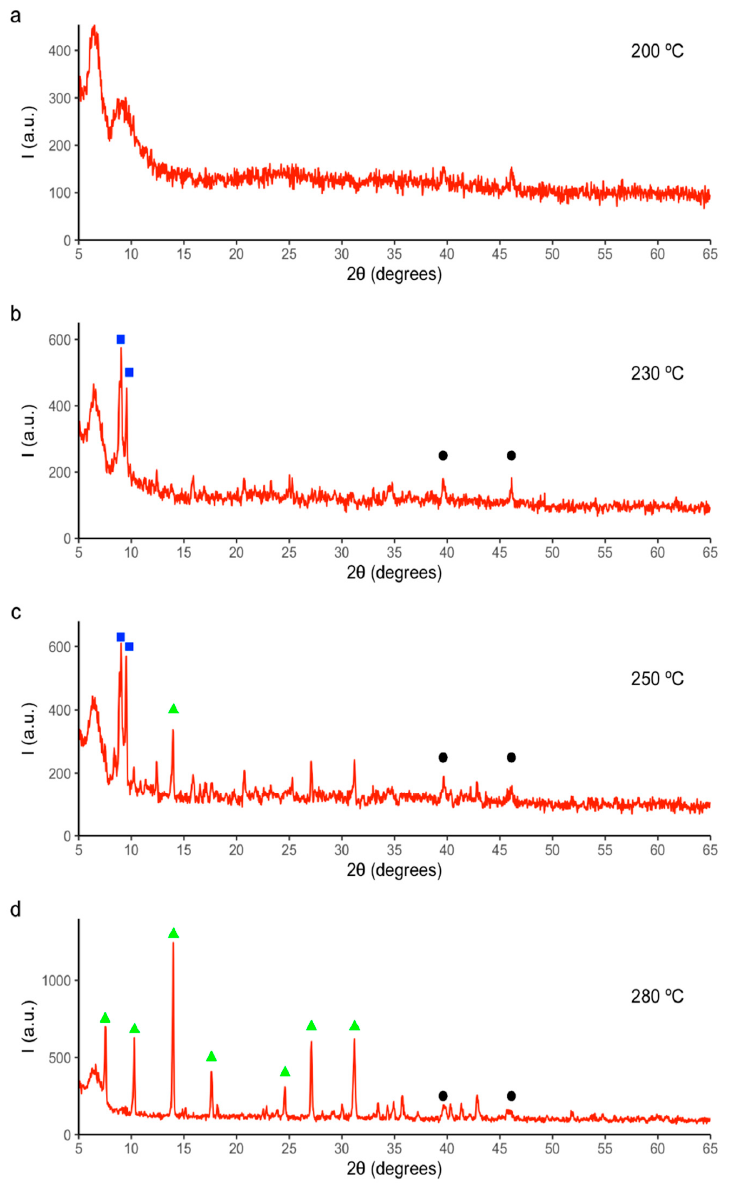
Figure 5. X-ray powder diffraction of cobalt acetate tetrahydrate commercial sample heated under N 2 atmosphere at ( a ) 200 °C, ( b ) 230 °C, ( c ) 250 °C, and ( d ) 280 °C. Main peaks of present phases are marked as follows: black circle for platinum (PDF-01-087-0642), green triangle for cobalt oxide acetate (PDF-00-022-0595), and blue square for an unknown phase. From 275 ◦ C (stage C in the TG curve), the sample continuously lost weight up to 370 ◦ C; this mass remained constant during the cooling process until room